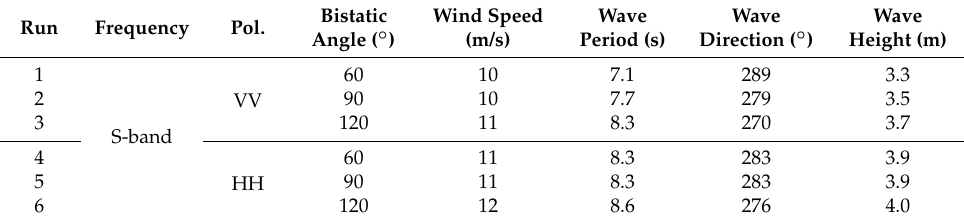
Table 1. Properties of the NetRAD radar sea clutter acquisitions investigated in this